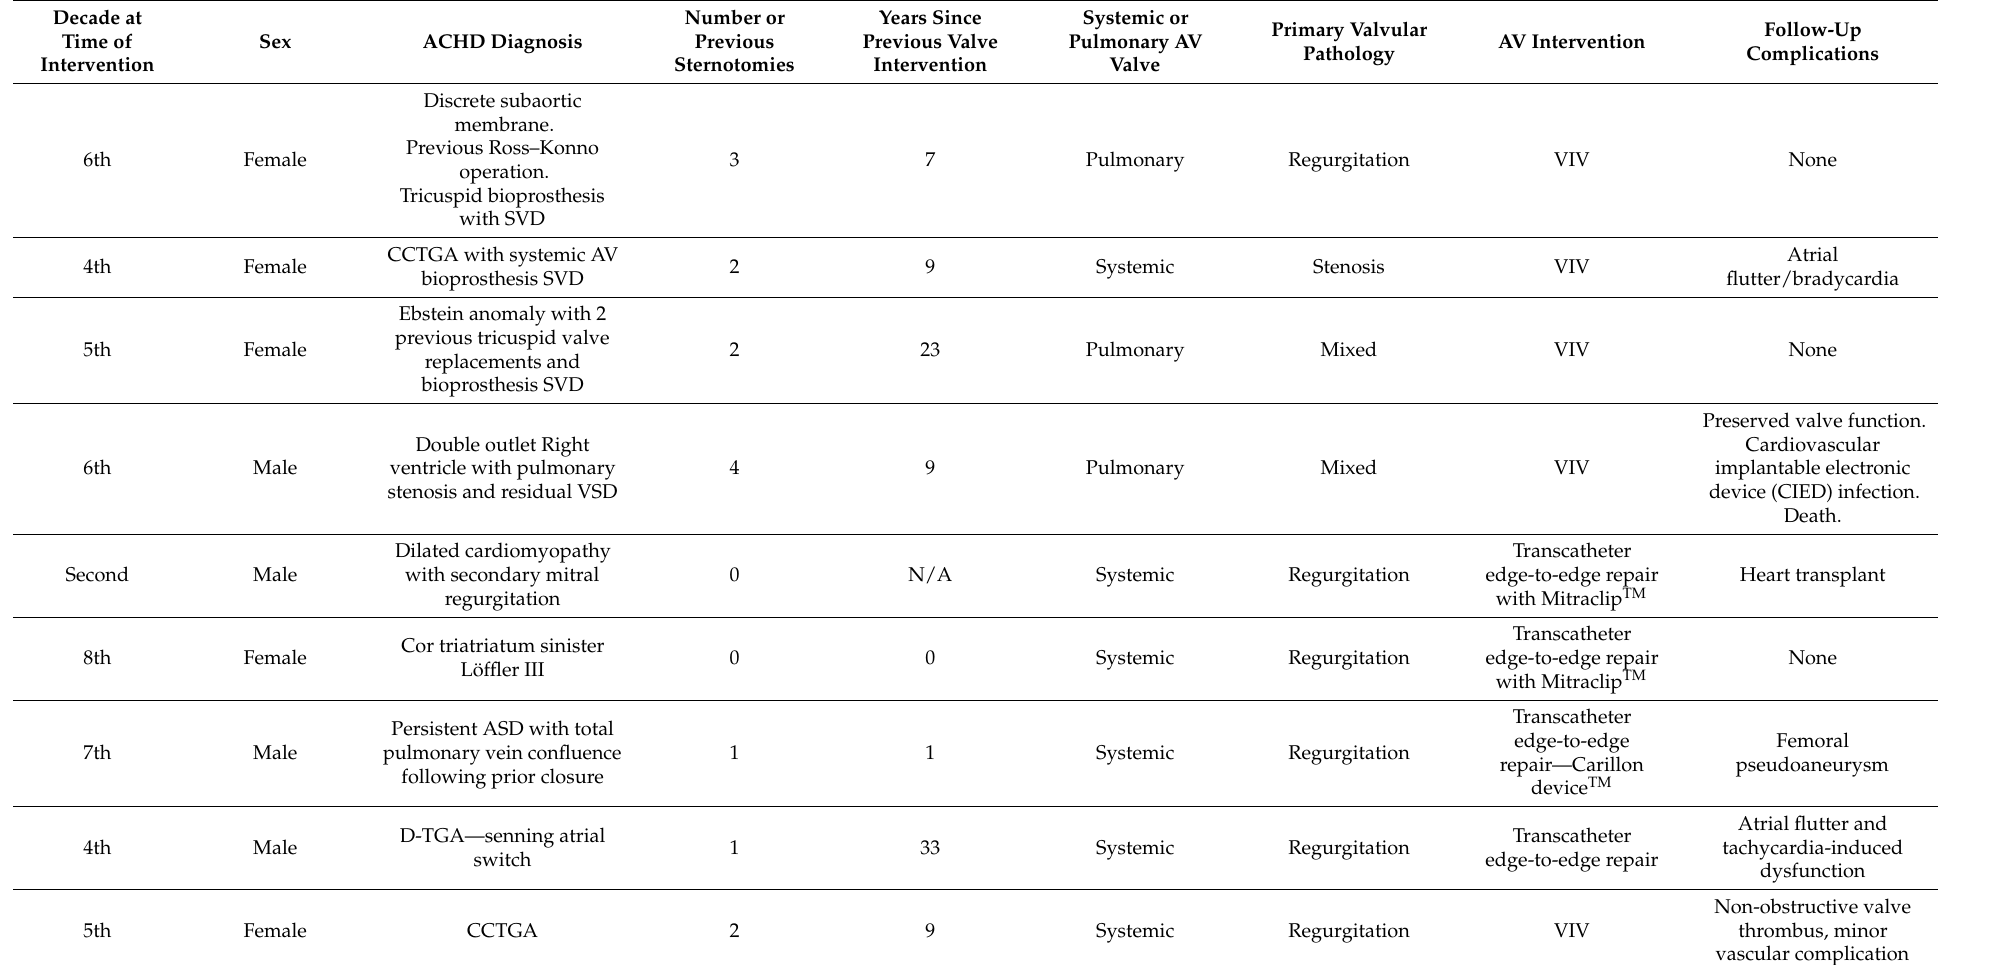
Table 1. Summary of clinical and procedural characteristics of the